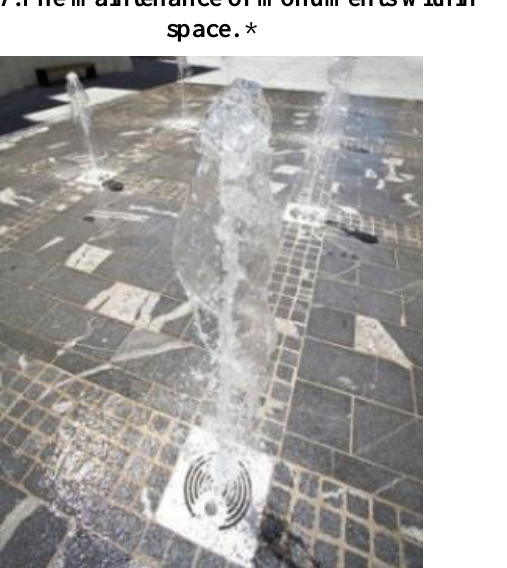
Fig. 10. Providing seating places under trees for concerts and outdoor cinemas .